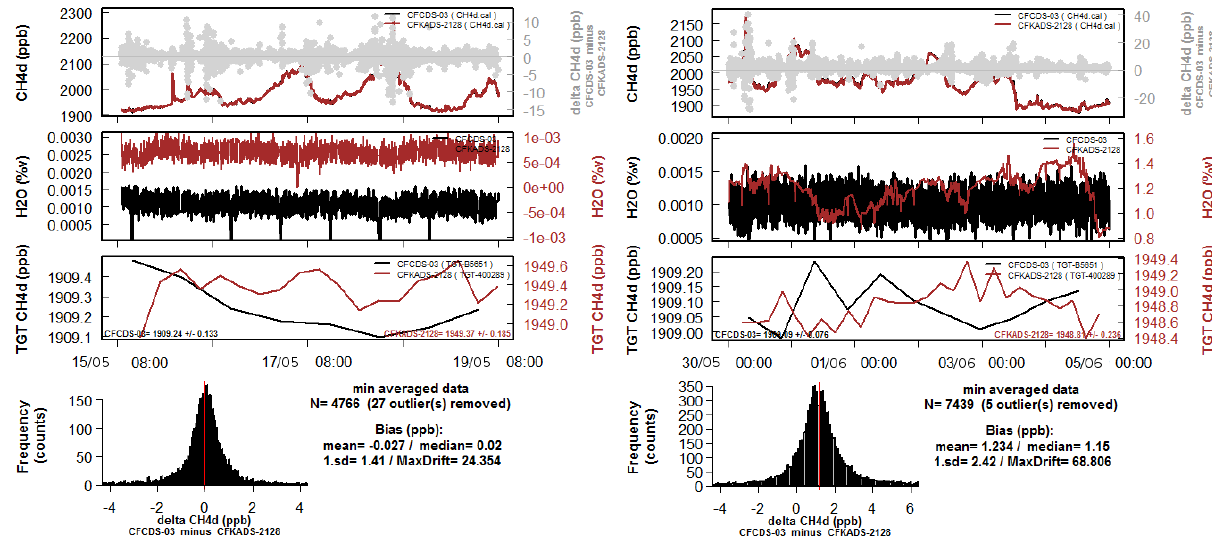
Figure A6. Comparison with the reference instrument for CH 4 . First panel: dry air vs. dry air. Second panel: wet air corrected for H 2 O vs. dry air. From top to bottom, the concentrations for both instruments and the difference of the two are plotted, then the water vapor concentrations for both instruments, then the evolution of the target for both instruments and finally a histogram of the distribution of the differences along with